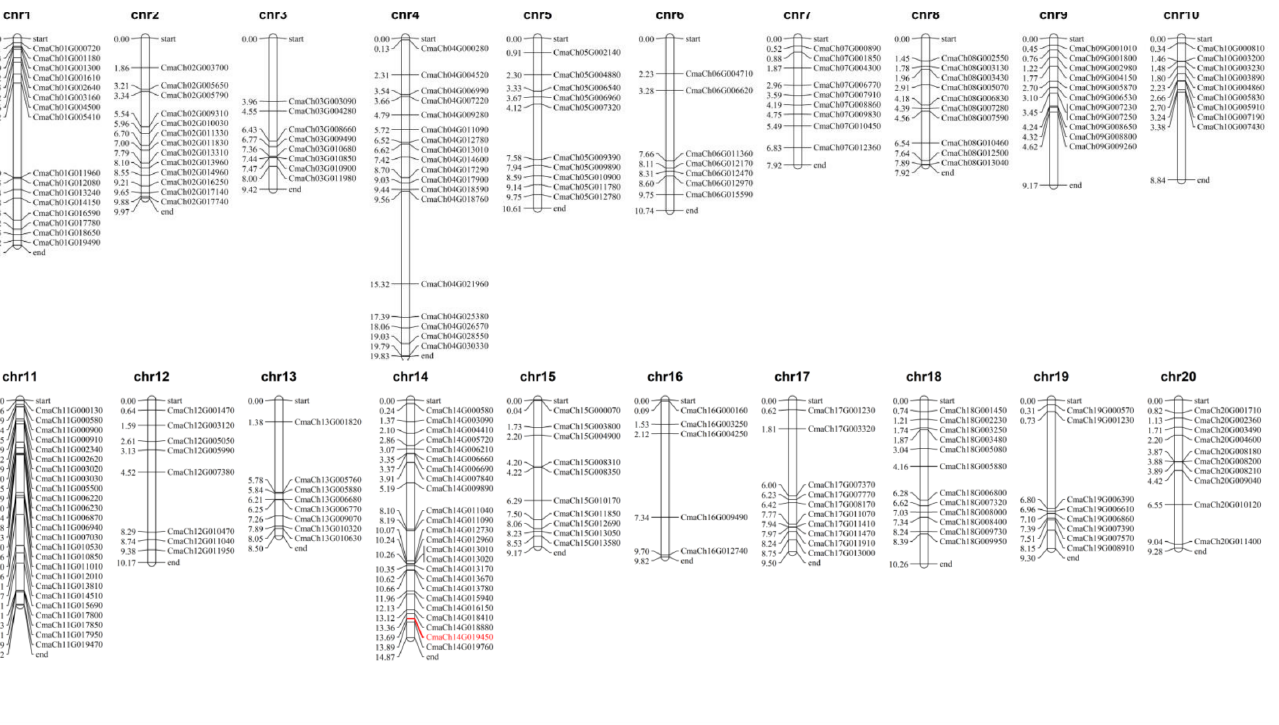
Figure 2. Uneven distribution of WD40 genes in C. maxima chromosomes. The bars represent chro- mosomes, and the black line on the olive bars indicate the location of WD40 genes on chromosomes. The number of chromosomes is represented at the top of each chromosome. Scale bar is in Megabase (Mb). The red part indicates the location of CmaCh14G019450 in Chr14. Gene family expansion and evolution are always accompanied by frequent tandem